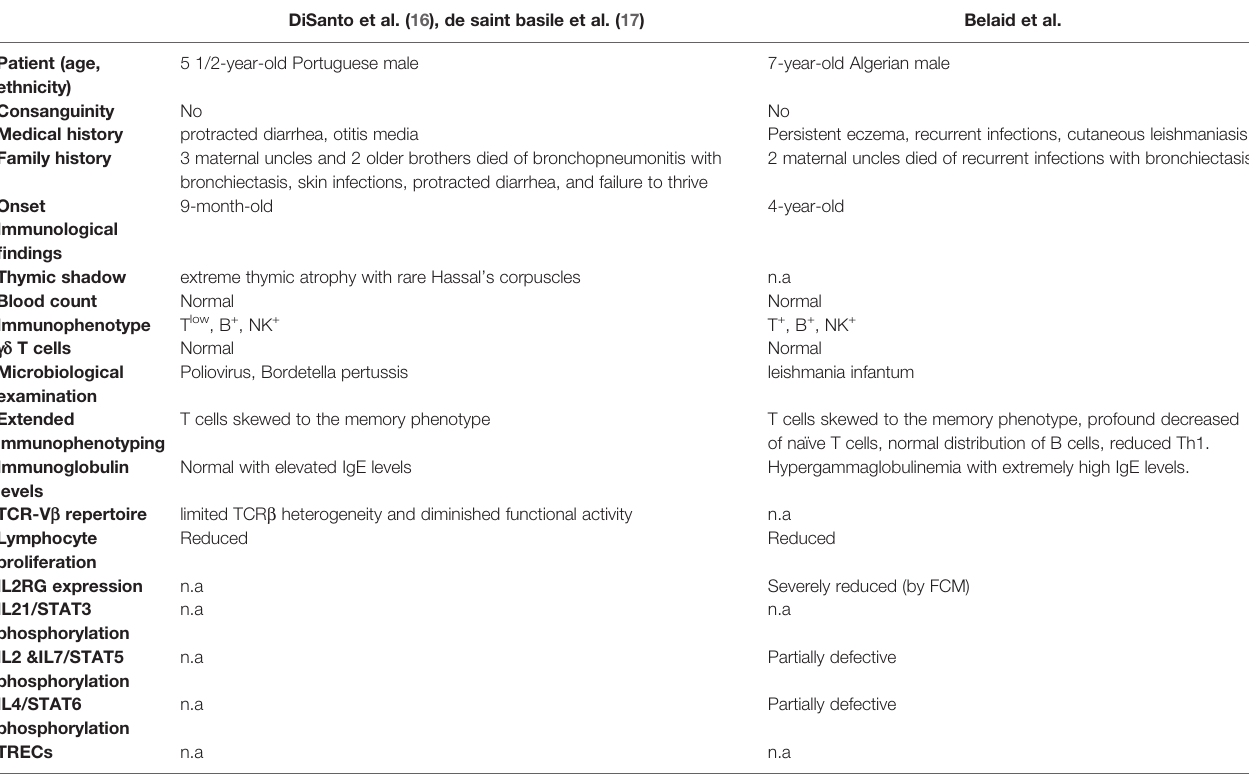
TABLE 2 | Characteristics of reported patient carrying the IL2RG 115G>A missense mutation. DiSanto et al. (16), de saint basile et al.